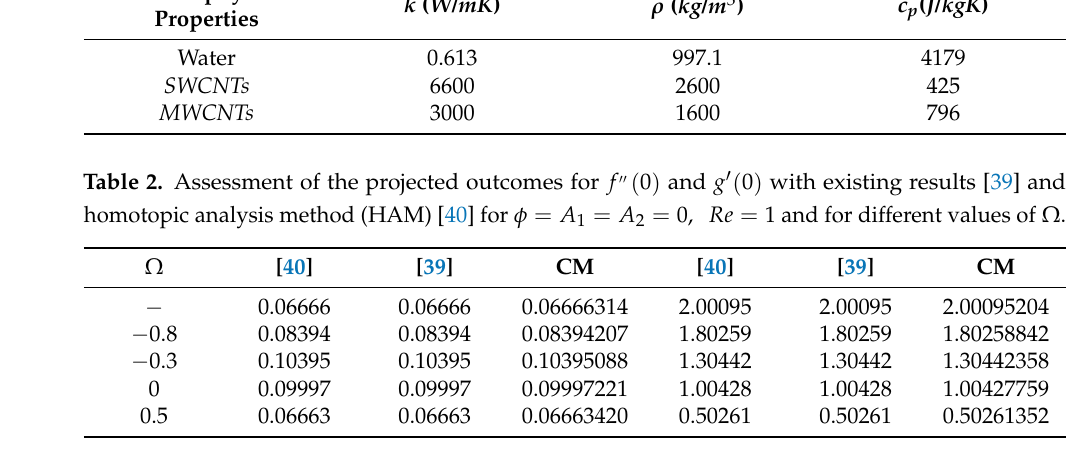
Table 3. Error investigation of axil and tangential velocities, and temperature profiles for SWCNTs Table 1. Thermo-physical properties of water and carbon nanotube for dissimilar values of when φ = 0.2, A 1 = 0.7 γ 2 = 0.5, γ 1 = 0.4, Ω = A 2 = 0.8, Rd = 0.3, and Re =